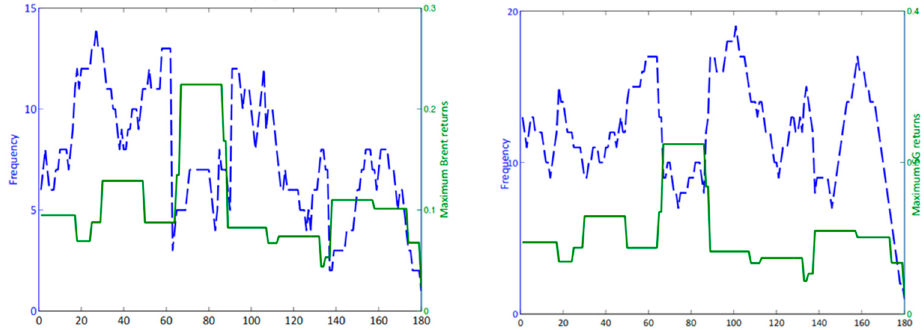
Figure 4. Brent ( left ) and SG ( right ) returns vs. clustering frequency.